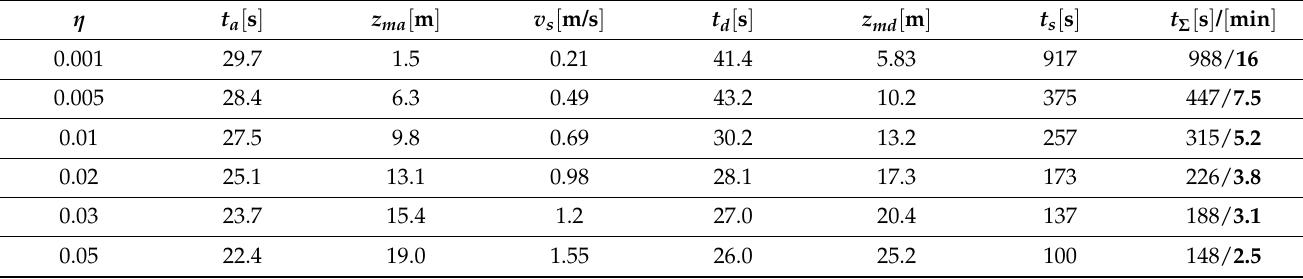
Figure 8. Speed of submersion of the cylinder from the start of deceleration until complete stop con- sidering the subsequent ascension for an instantaneous change in buoyancy ( t 0 = 0 ) from − η to η . Table 1. Dependence of the full time of submersion of the cylinder on the change in relative volume of replacement for H = 200 m, l = 2 m, t 0 = 20